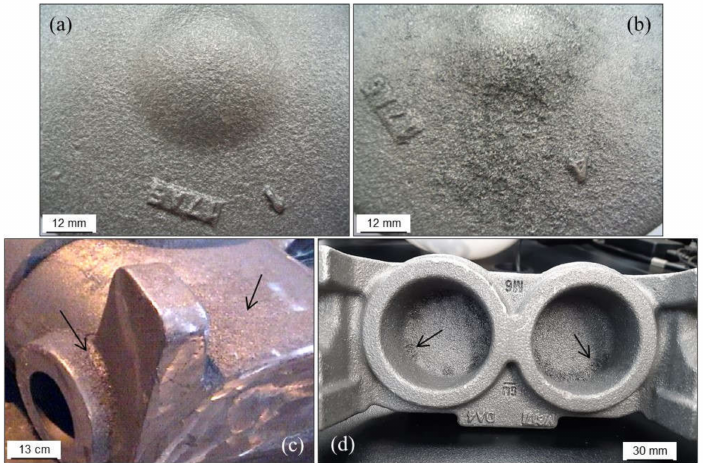
Figure 15. Burn-in or calcination defects: ( a , b ) comparison of same surface in ductile iron castings without and with a slight defect which can be confused with a poor surface finish; ( c ) burned-in sand on a plate surface and in internal angles of a heavy-section grey iron casting; ( d ) calcinations located in internal angles of the hydraulic areas (hot spots) of a ductile iron